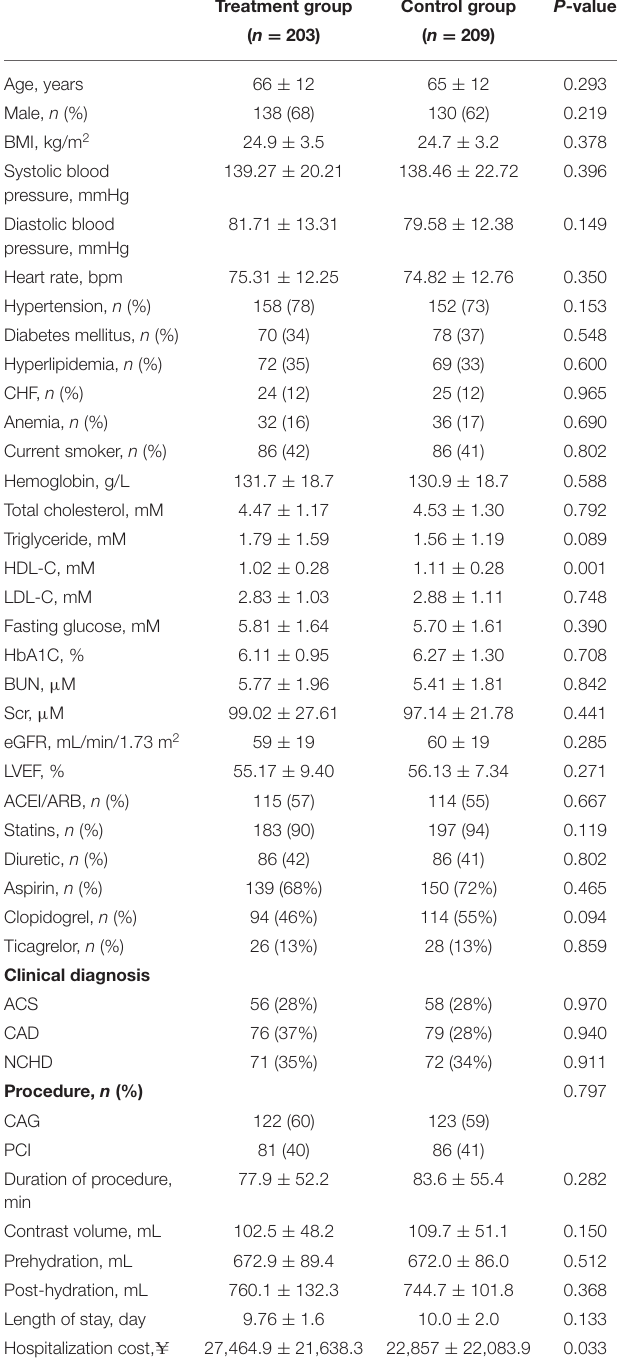
TABLE 1 | Baseline characteristics of patients with hyperhomocysteinemia receiving folic acid vs. a control group. Treatment group Control